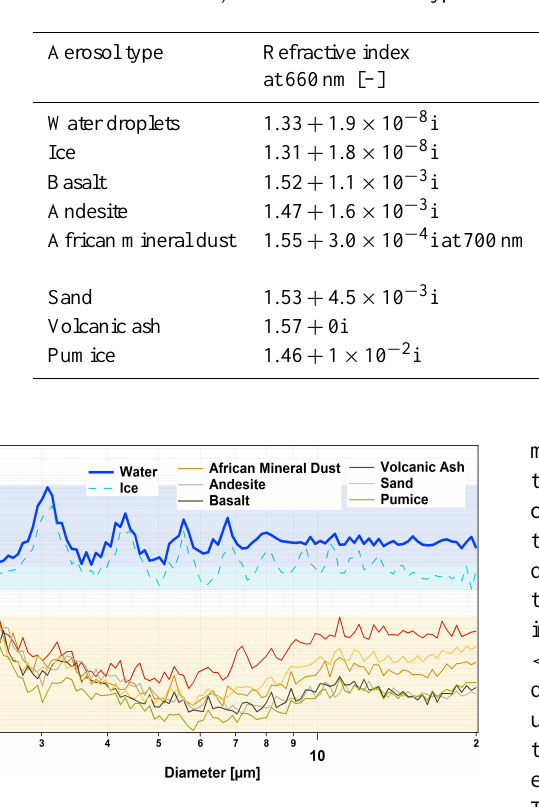
Table 1. The refractive index of water, ice and different dust types at 660 and 2750nm wavelength.